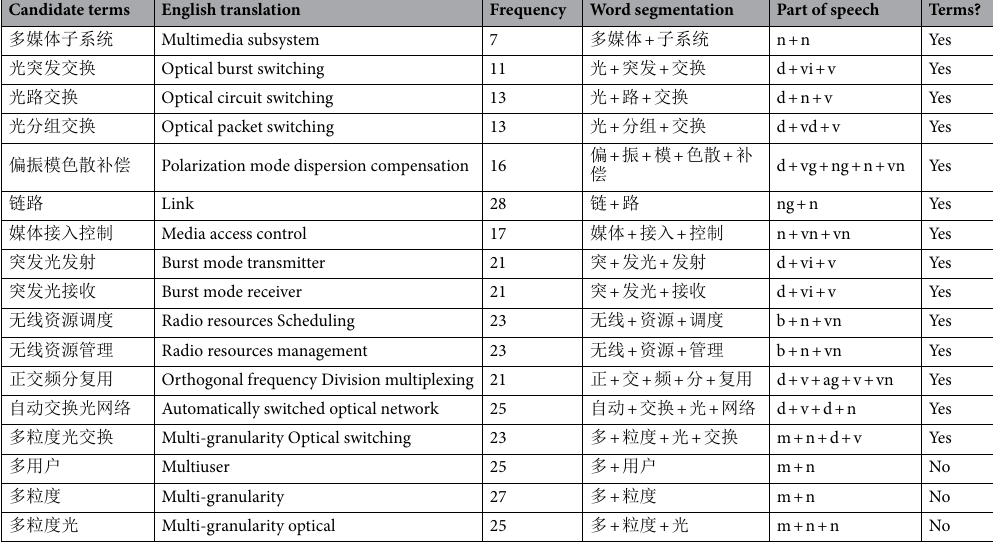
Table 3. Terminology extraction